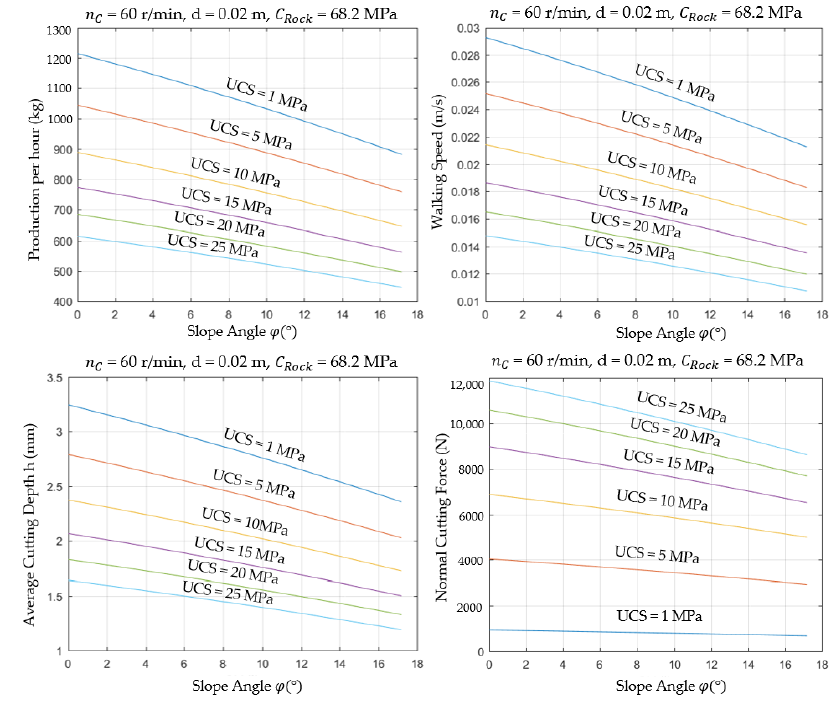
Figure 15. The working performance of the mining vehicle.